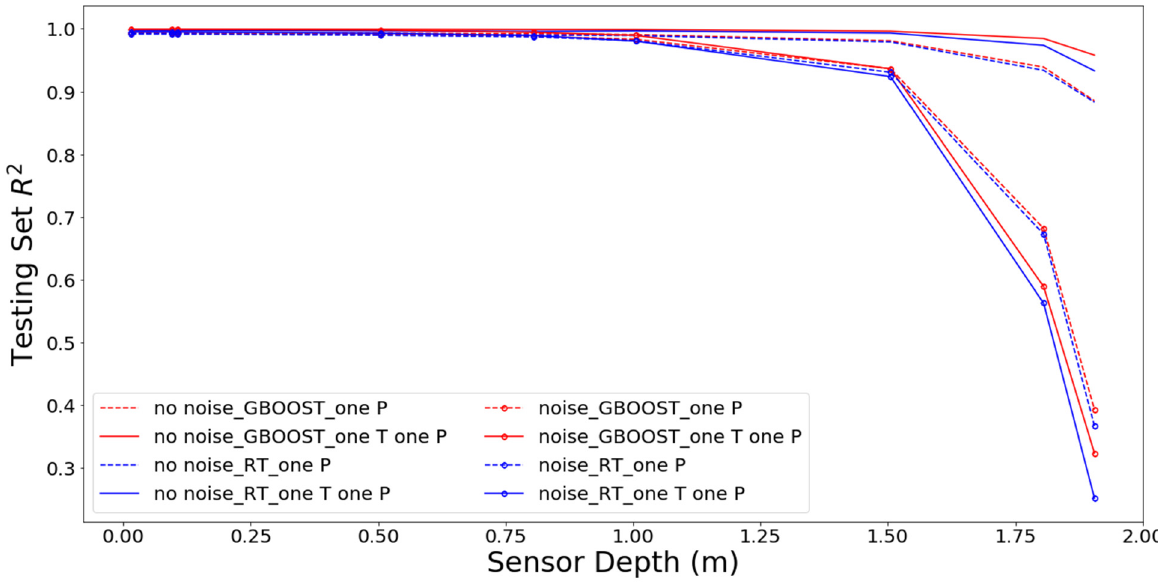
Figure 8. Performance of one pressure sensor and a combined pressure and temperature observation set with respect to the depth of installation considering the influence of measurement error and whether GB was used for the analysis.